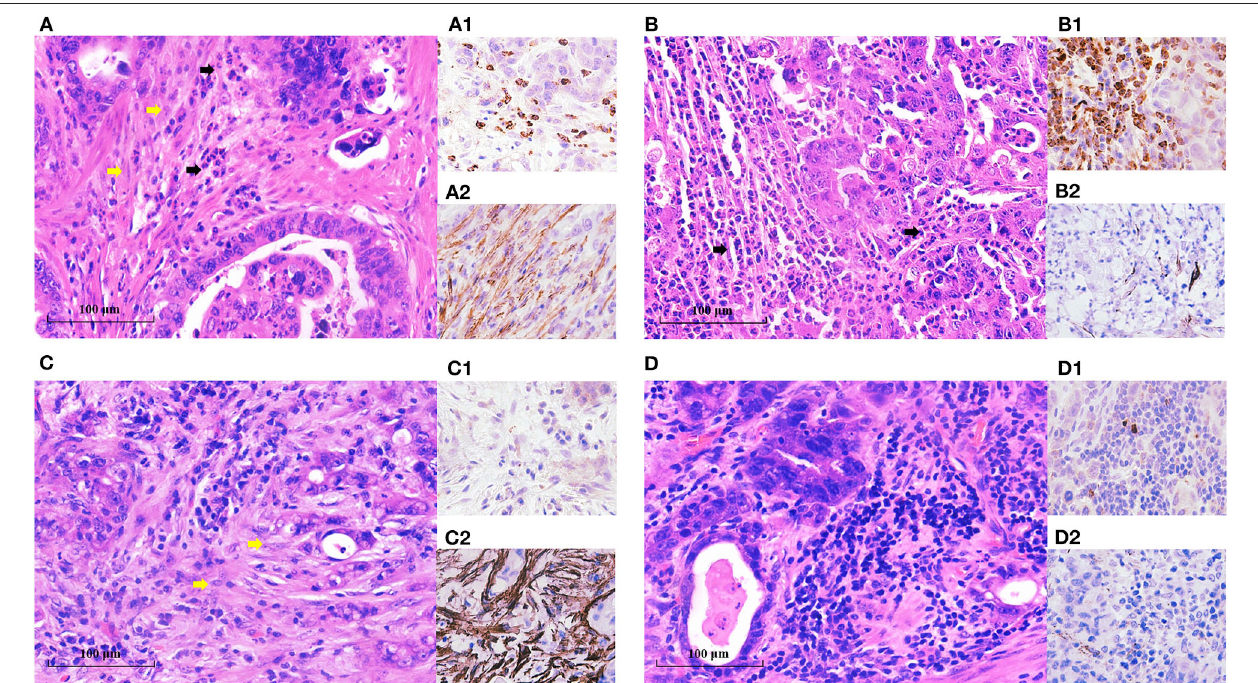
FIGURE 1 | TANs and CAFs in gastric cancer tissues. TANs and CAFs were detected in the tumor stroma of all these EGC patients by H&E staining and IHC. (A) Both the high-TAN and high-CAF groups: more than 10 TANs per HPF (black arrow) were detected, and CAFs (yellow arrow) accounted for more than 50% of tumor stroma. (B) The high-TAN group with low CAFs: more than 10 TANs per HPF (black arrow) were detected, and CAFs accounted for < 50% of tumor stroma. (C) The low-TAN group with high CAFs: < 10 TANs per HPF were detected, and CAFs (yellow arrow) accounted for more than 50% of tumor stroma. (D) The low-TAN group with low CAFs: < 10 TANs per HPF were detected, and CAFs accounted for < 50% of tumor stroma. ( A1 , B1 , C1 , D1 ) TANs using MPO staining. ( A2 , B2 , C2 , D2 ) CAFs using α -SMA staining.